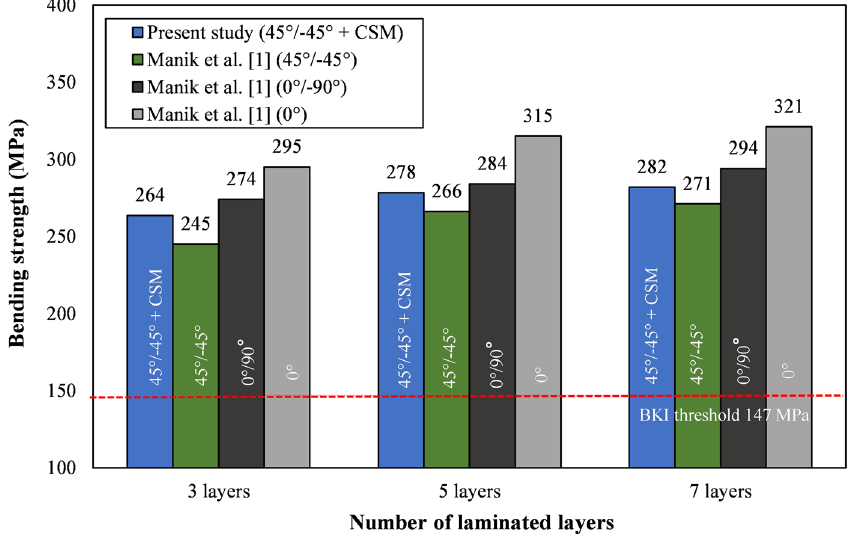
Figure 6: Comparison of bending strength under di ff erent numbers of